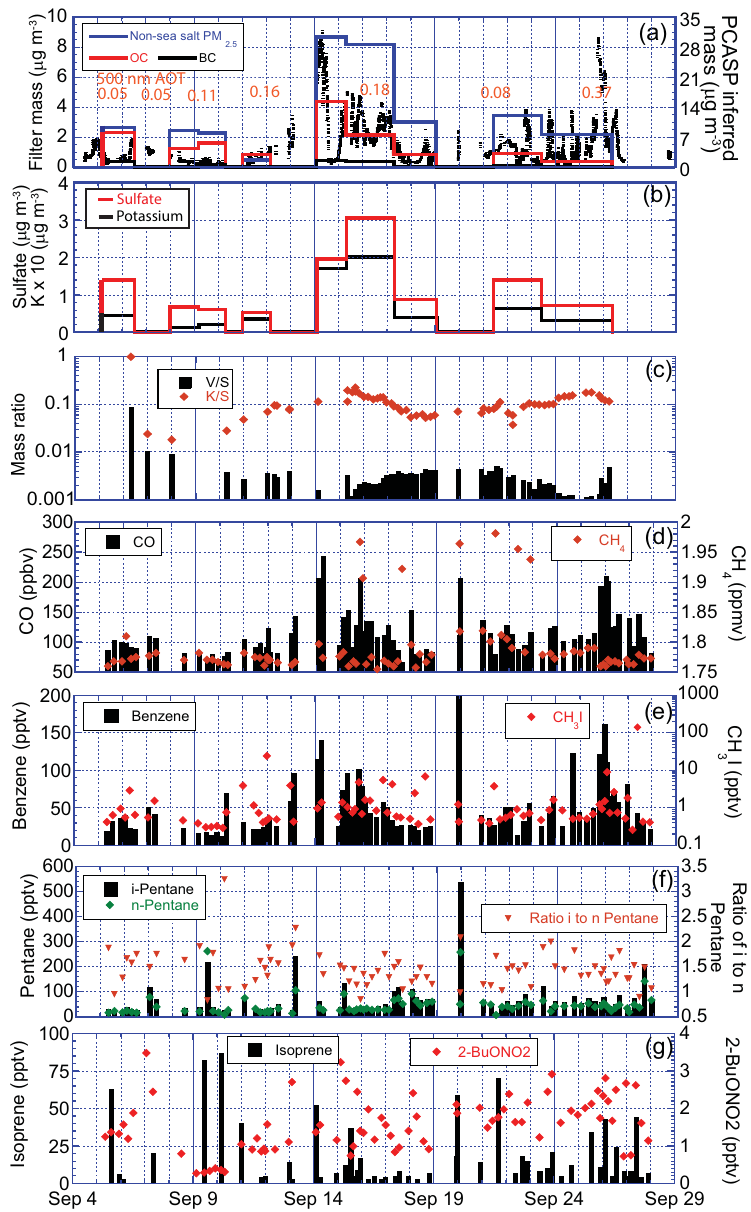
Figure 5. Time series of chemistry measurements including (a) filter-based gravimetry and organic carbon and black carbon. Also shown is 30min averaged fine mass inferred from the PCASP, assuming a density of 1.35gcm − 3 . Labeled are 500nm AOT from the MAN Microtops sun photometer; (b) filter sulfate and potassium; (c) DRUM sampler elemental ratios of vanadium and potassium to sulfur; (d) whole- air sampled CO and methane; (e) whole-air sampled benzene and methyl iodide; (f) whole-air sampled i - and n -pentane with their ratio; (g) whole-air sampled isoprene and 2-butyl alkyl